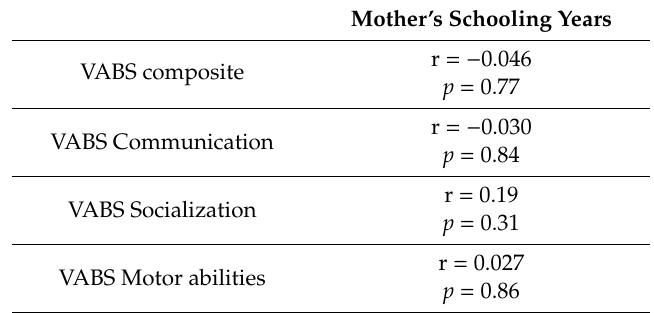
Table 3. Spearman’s correlations between maternal education and developmental skills. Mother’s Schooling Years r = − VABS composite